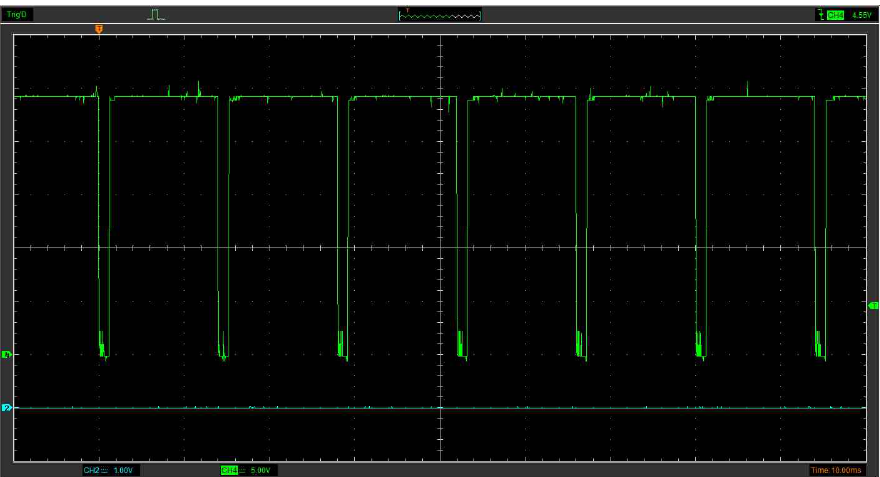
Figure 2. Oscillograms from transmission